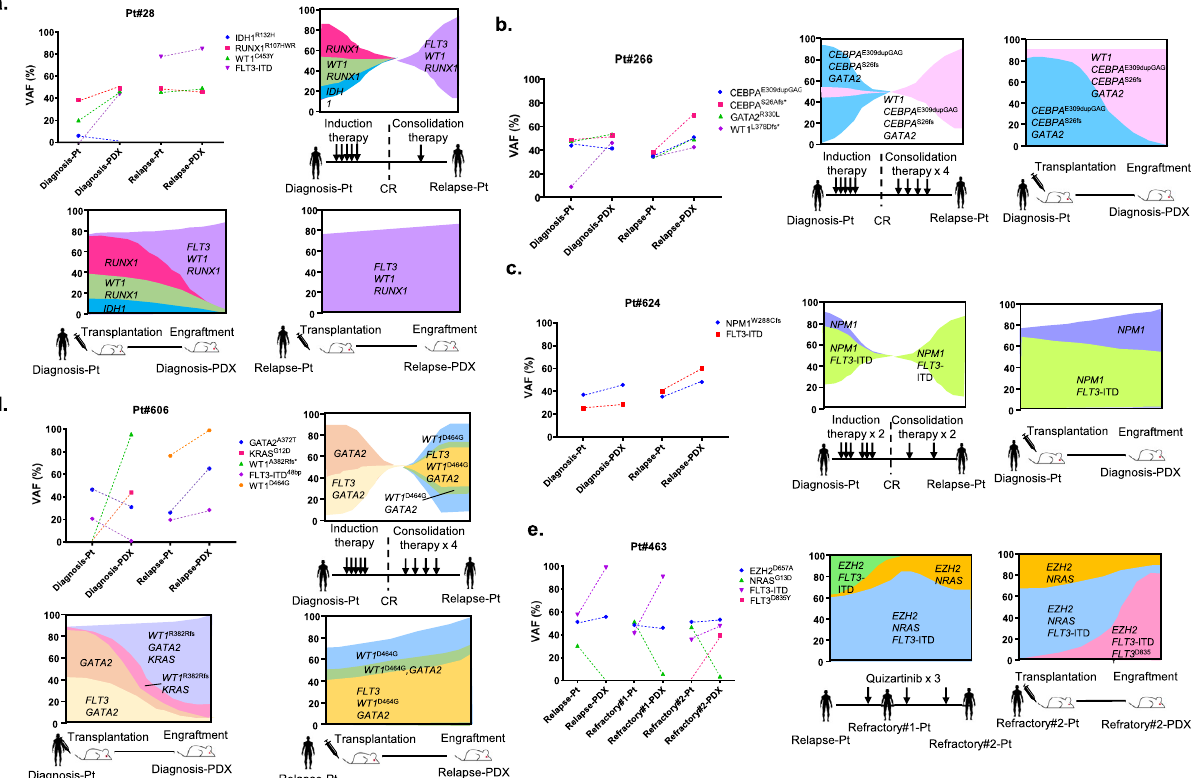
Fig. 6 Serial mutational spectrum and clonal changes in AML patients and their PDX models. In each patient, clonal changes in the clinical course and PDX engraftment are shown in the fi sh plot format. a , b Illustrative cases showing that selectively expanded clones in PDX were consistent with clonality at relapse in patients. c A case in which dominant clones consisting of FLT3 -ITD and NPM1 mutations persisted in patients at relapse and PDX at engraftment. d A case in which mouse-speci fi c enrichment that did not evolve in a relapsed patient. e A case showing the expansion of a FLT3 inhibitor-resistant clone in PDX. Source data are provided as a Source Data fi